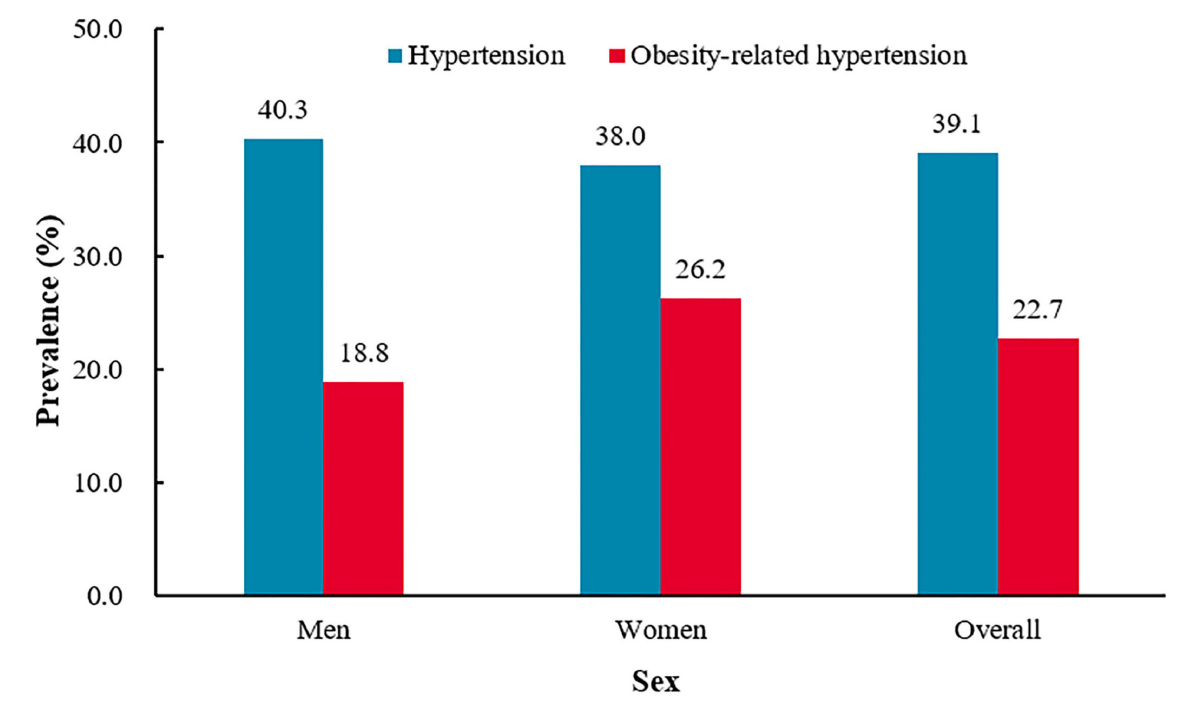
FIGURE1 The prevalence of hypertension and obesity-related hypertension among China adults aged 45 years or older. † P = 0.0179 for sex difference in the prevalence of hypertension. ‡ P = 0.0001 for sex difference in the prevalence of obesity-related